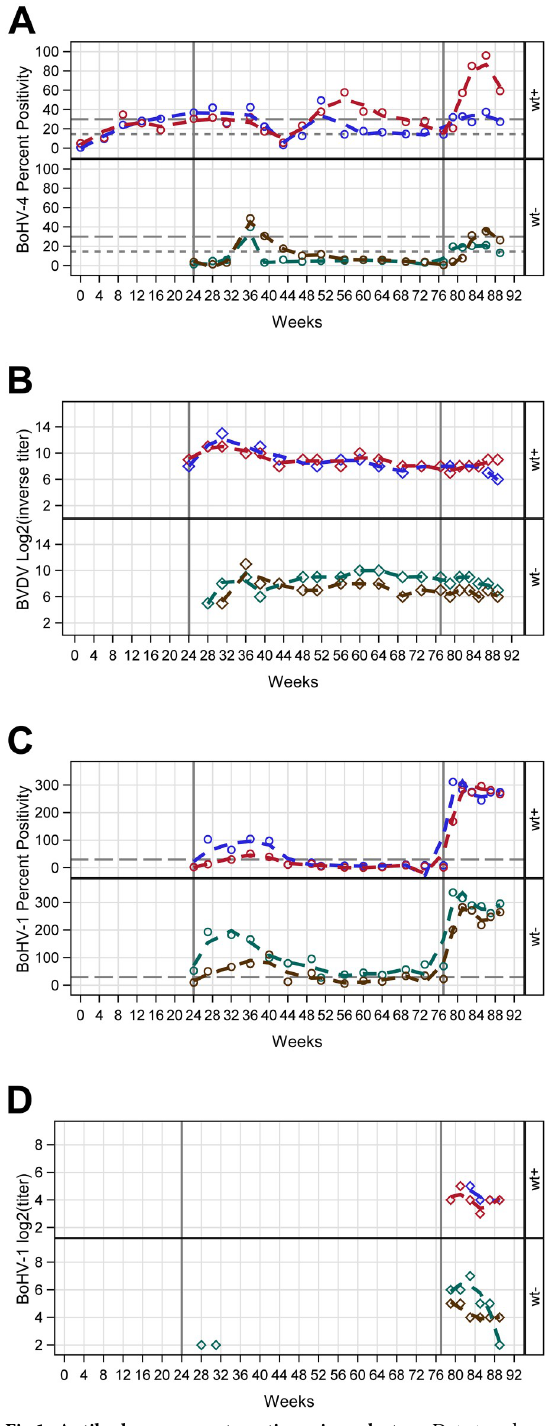
Fig 1. Antibody responses to antigens in each steer. Data trends were fit by Loess (degree = 2, smoothing = 0.3), and original data are shown as symbols. The solid gray lines indicate positive cut-off values as suggested by the kit manufacturer for each respective ELISA kit, and the dotted grey line indicates the positive cut-off value as calculated for the geographical region. Steers 1 (blue) and 2 (red) (top) were WT-BoHV-4- infected (wt +) and steers 3 (green) and 4 (brown) (bottom) were immunized only with BoHV-4-A-CMV-IgK-gE2gD-TM (wt -). WT-BoHV-4 infection is indicated in the first 24 weeks, immunization with BoHV-4-A-CMV-IgK-gE2gD-TM occurred at week 24, and dexamethasone-induced suppression took place during week 77. Panel A. BoHV-4 antibody percent positivity